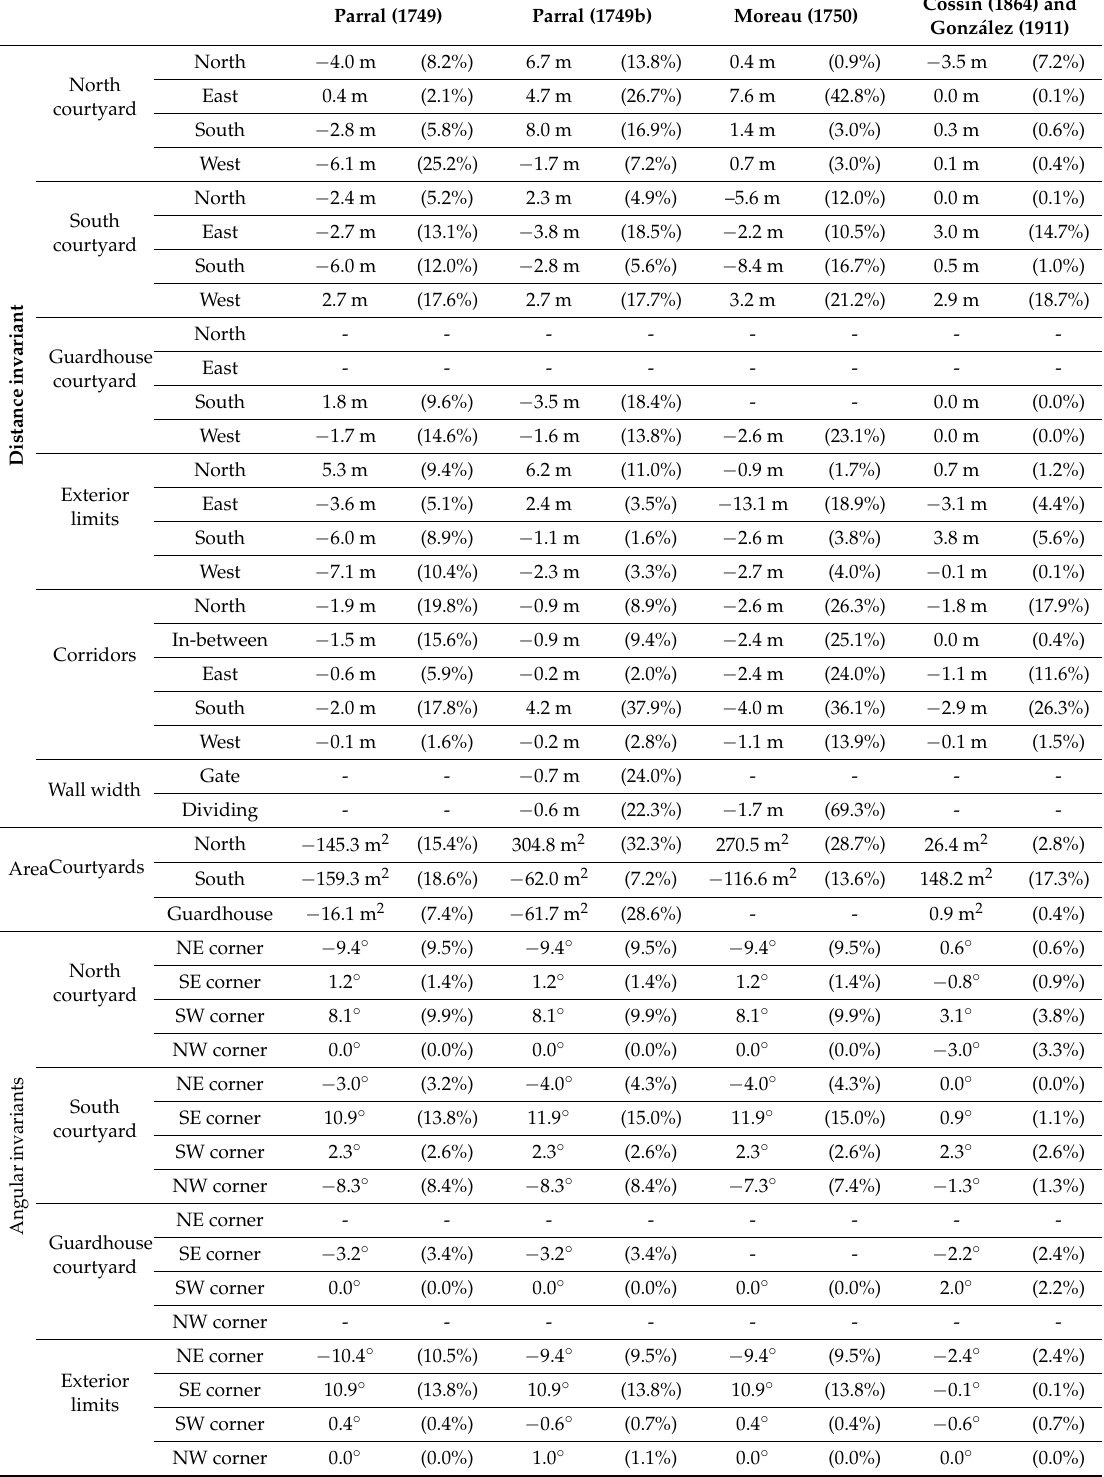
Table 2. Geometrical invariant discrepancies for the Alc á zar 4D modeling for the period that was used as